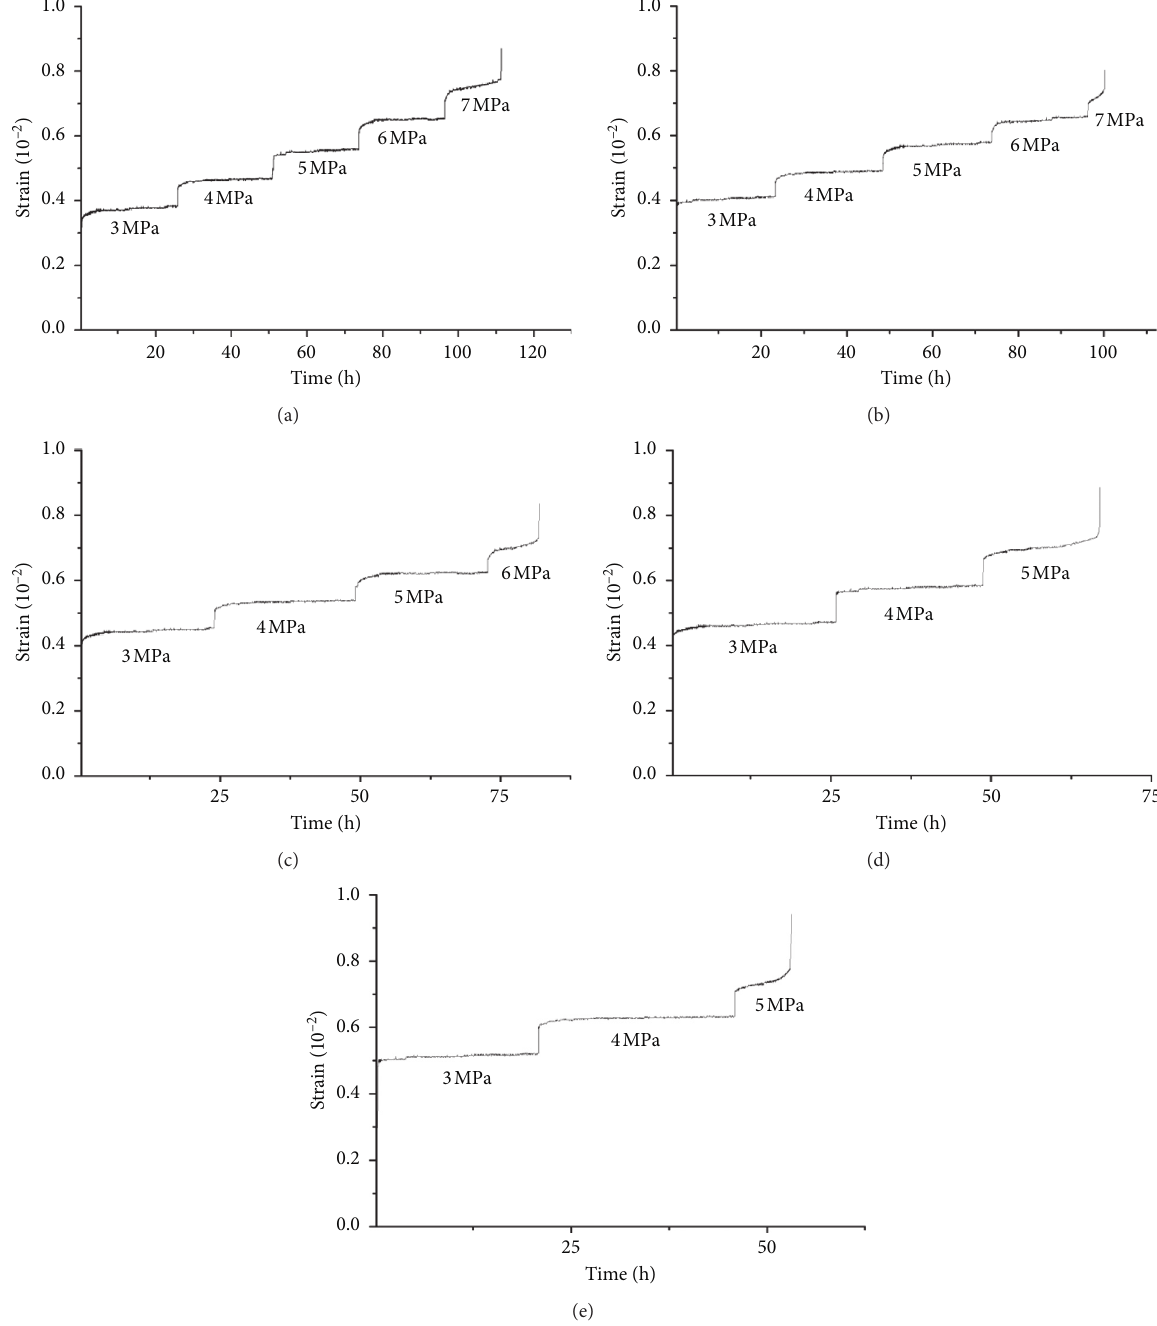
Figure 12: Creep test strain–time curve of backfill under different water pressures. (a) 0 MPa water pressure. (b) 0.5 MPa water pressure. (c) 1.0MPa water pressure. (d) 1.5MPa water pressure. (e) 2.0MPa water